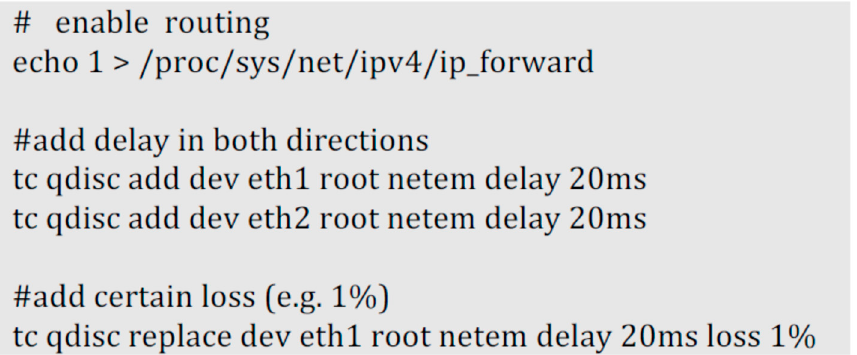
Figure 9. Linux router configuration commands.